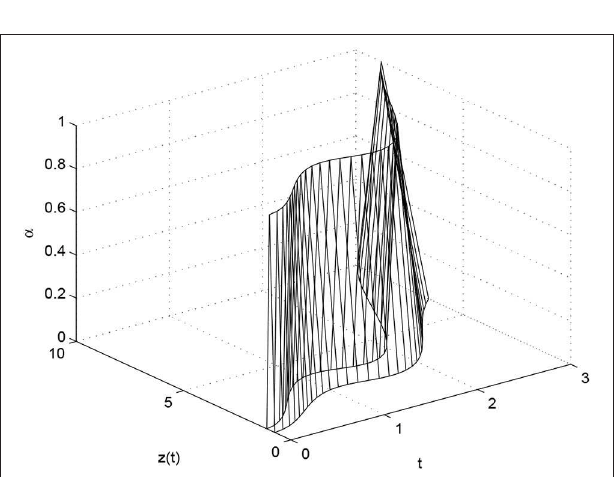
FIGURE 3 | Approximate solution by R-K-4 (for h = 0.1, α ∈ [0,1] for t ∈